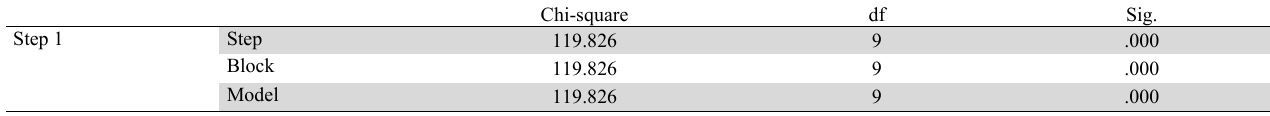
Omnibus Tests of Model Coefficients